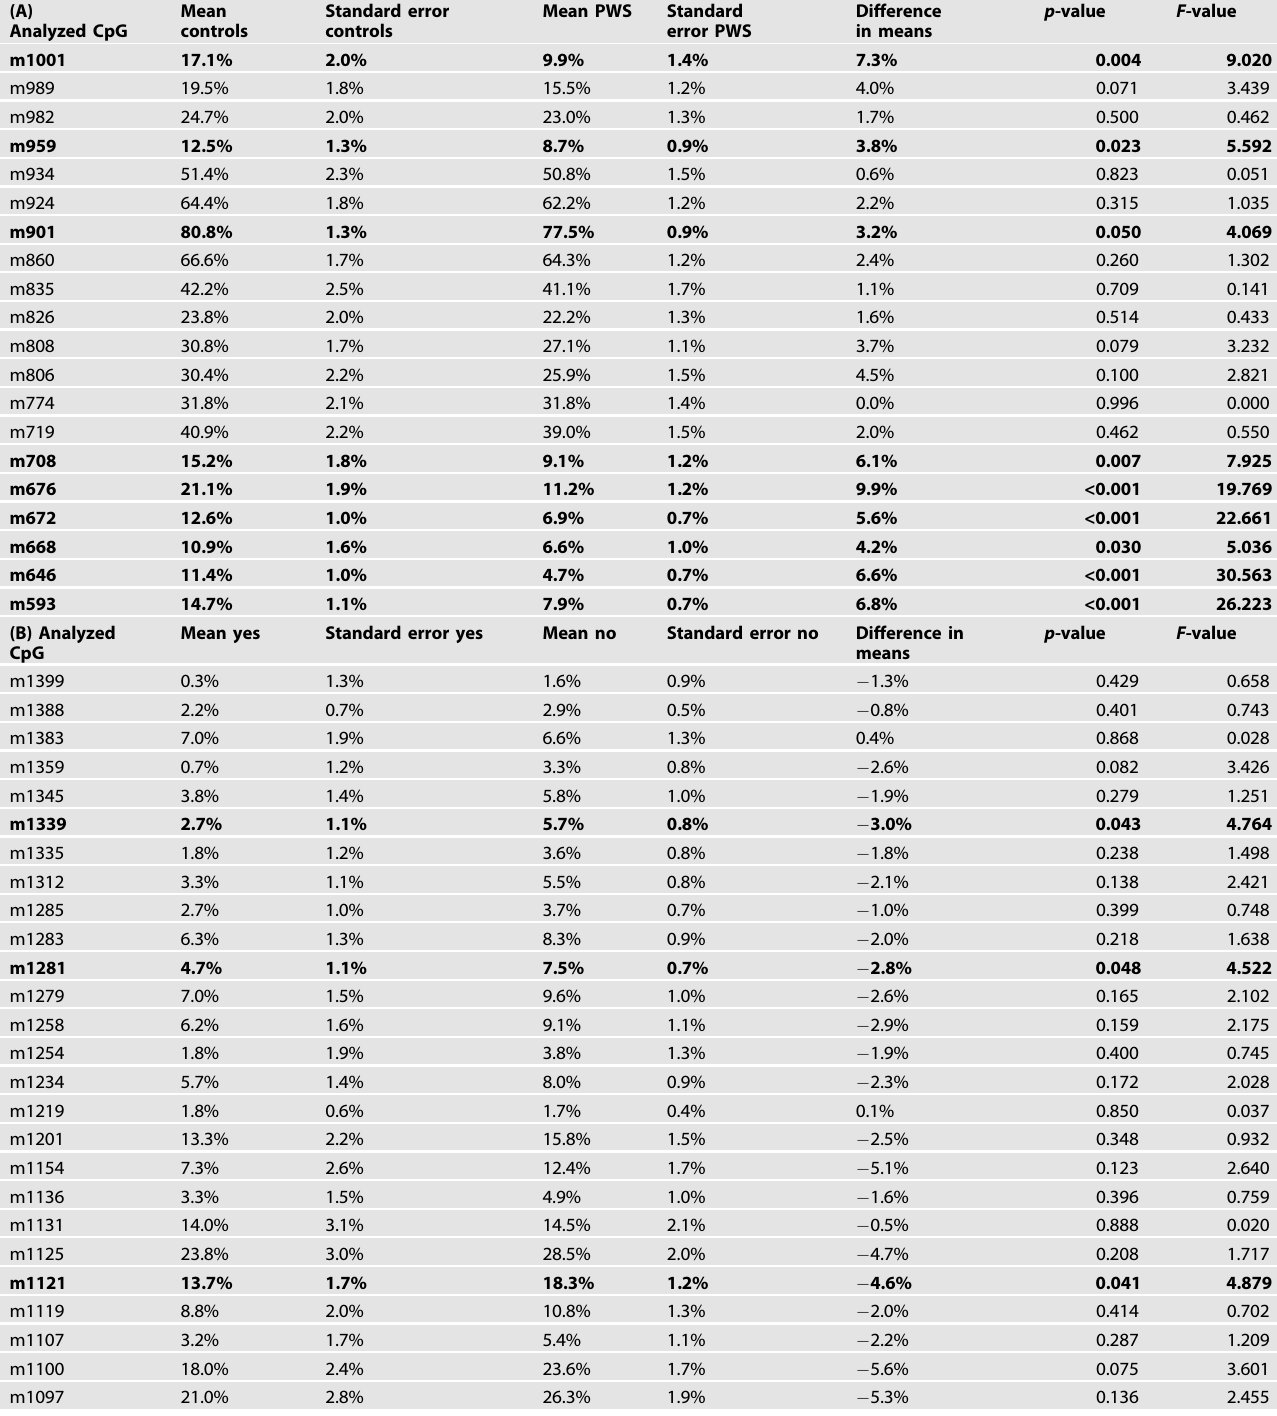
Table 2. A: Comparison of methylation rates at single-CpG sites in controls and PWS subjects in the intron 1 region. B: Comparison of methylation rates at single-CpG sites in male PWS subjects with psychosis (yes) and without psychosis (no) in the exon 1 region. (A) Mean Standard error Analyzed CpG controls